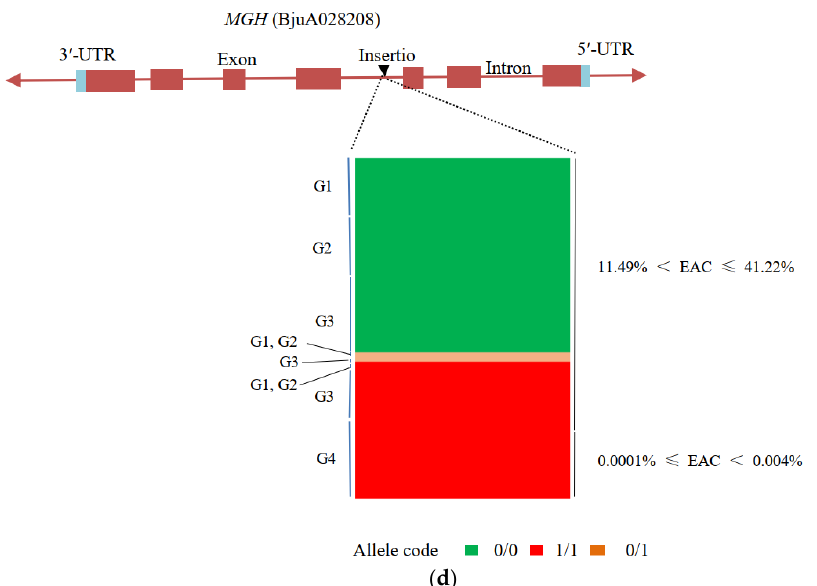
Figure 2. Genome-wide screening of selective sweeps and GWAS for erucic acid content in B. juncea . ( a ) Manhattan plot of F ST and θ π ratio detection of selective sweeps identified from the comparisons between G3 and G5; candidate genes associated with erucic acid content are highlighted. ( b ) GWAS results of erucic acid content. Dashed horizontal lines depict the significant ( − log 10 (P) = 9.0) and suggestive (−log 10 (P) = 8.0) thresholds. ( c ) Haplotypes for the candidate gene FAE1 (BjuB032118). ( d ) Haplotypes for the candidate gene MGH (BjuA028028).